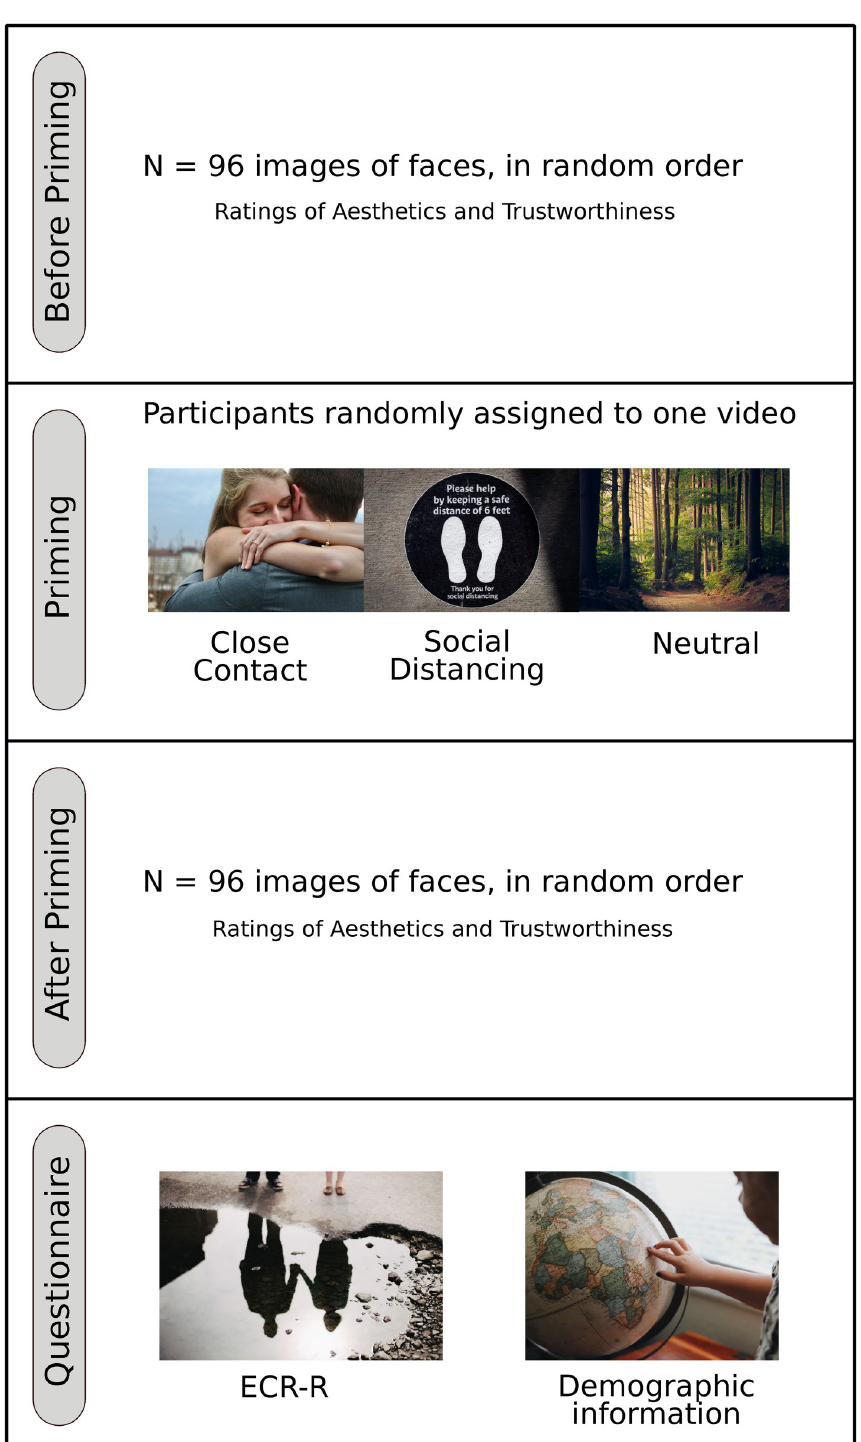
Fig 1. Visual representation of the experimental paradigm.